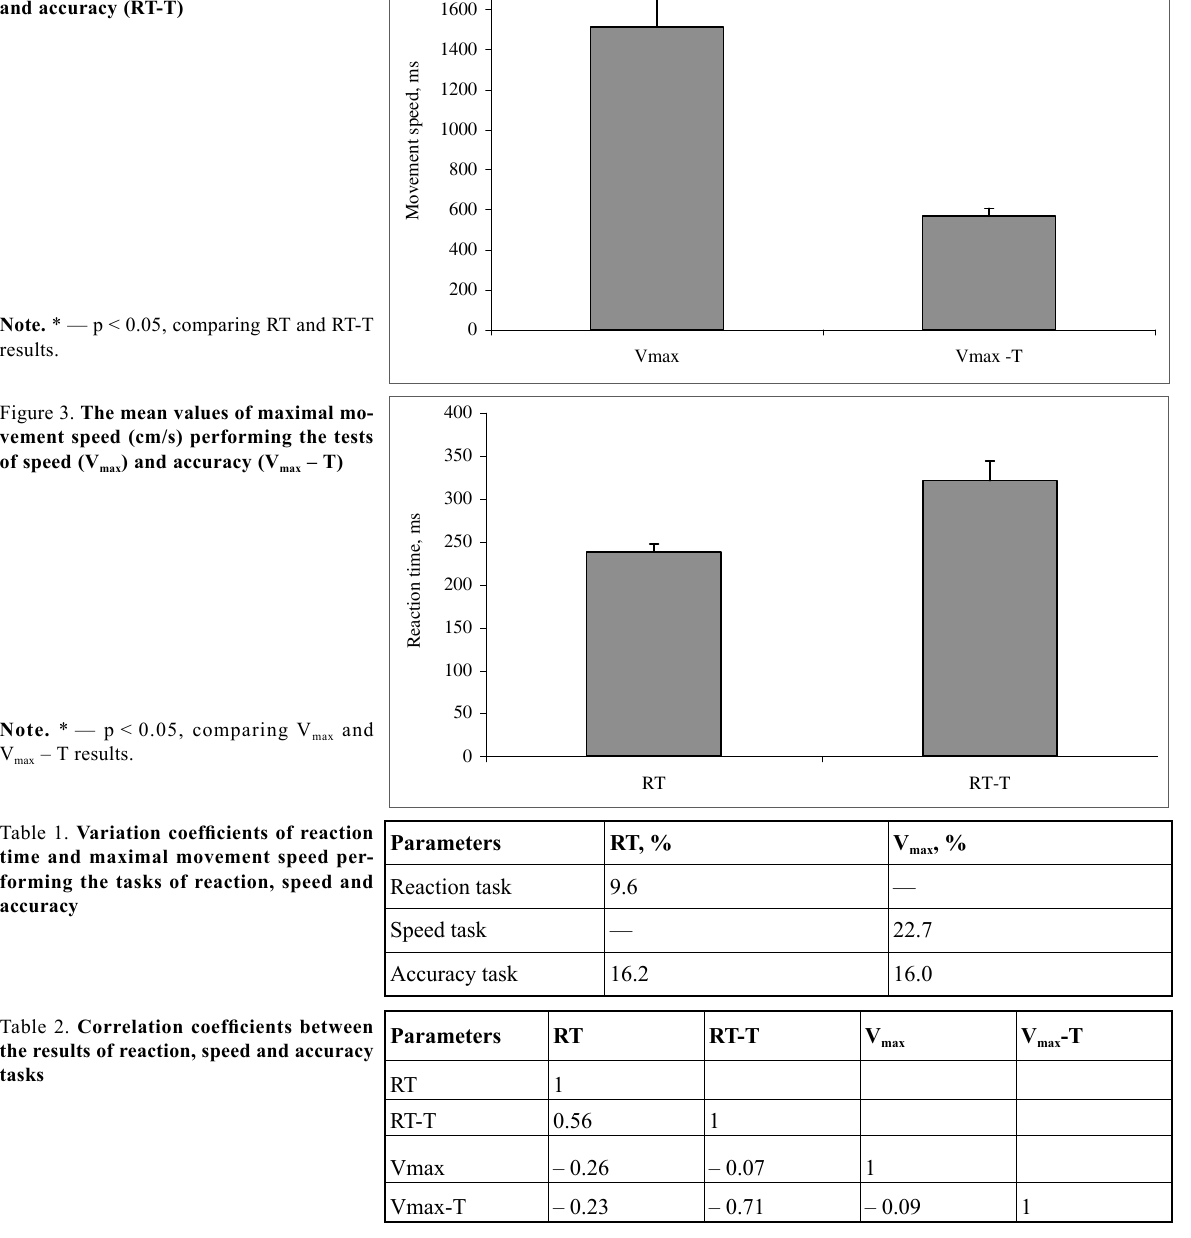
Figure 2. The mean values of reaction time (ms) performing the tasks of reaction (RT) and accuracy (RT-T)